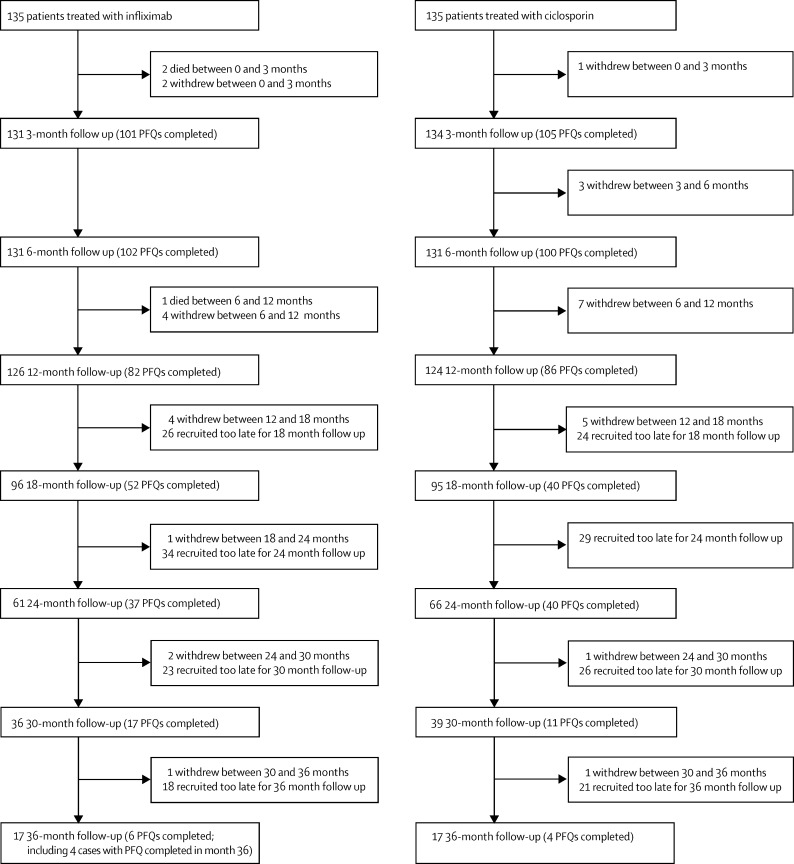
Patients included in follow-upPFQ=participant follow-up questionnaire.